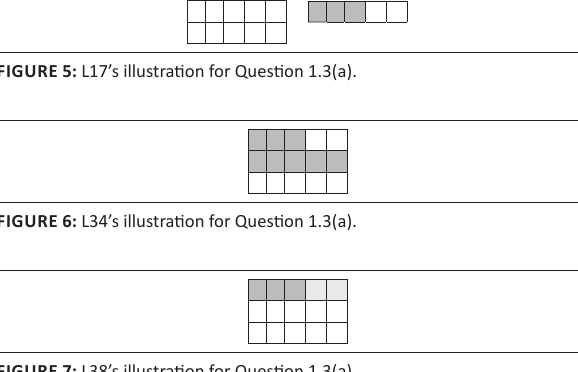
FIGURE 7: L38’s illustration for Question 1.3(a). TABLE 6: Verbal responses of L6 on Question 1.3(a) and (b). Item